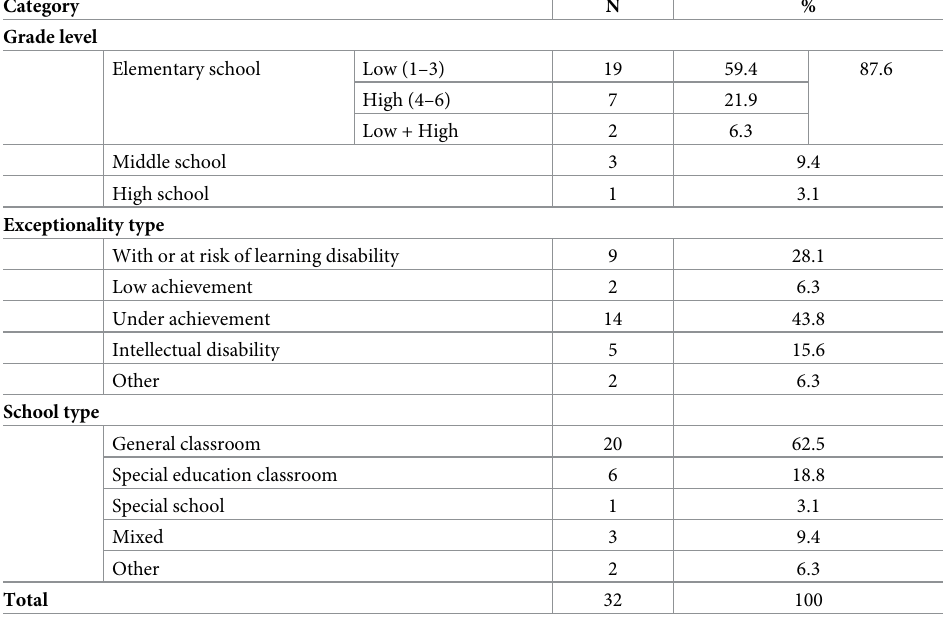
Table 4. Participant-related characteristics of the